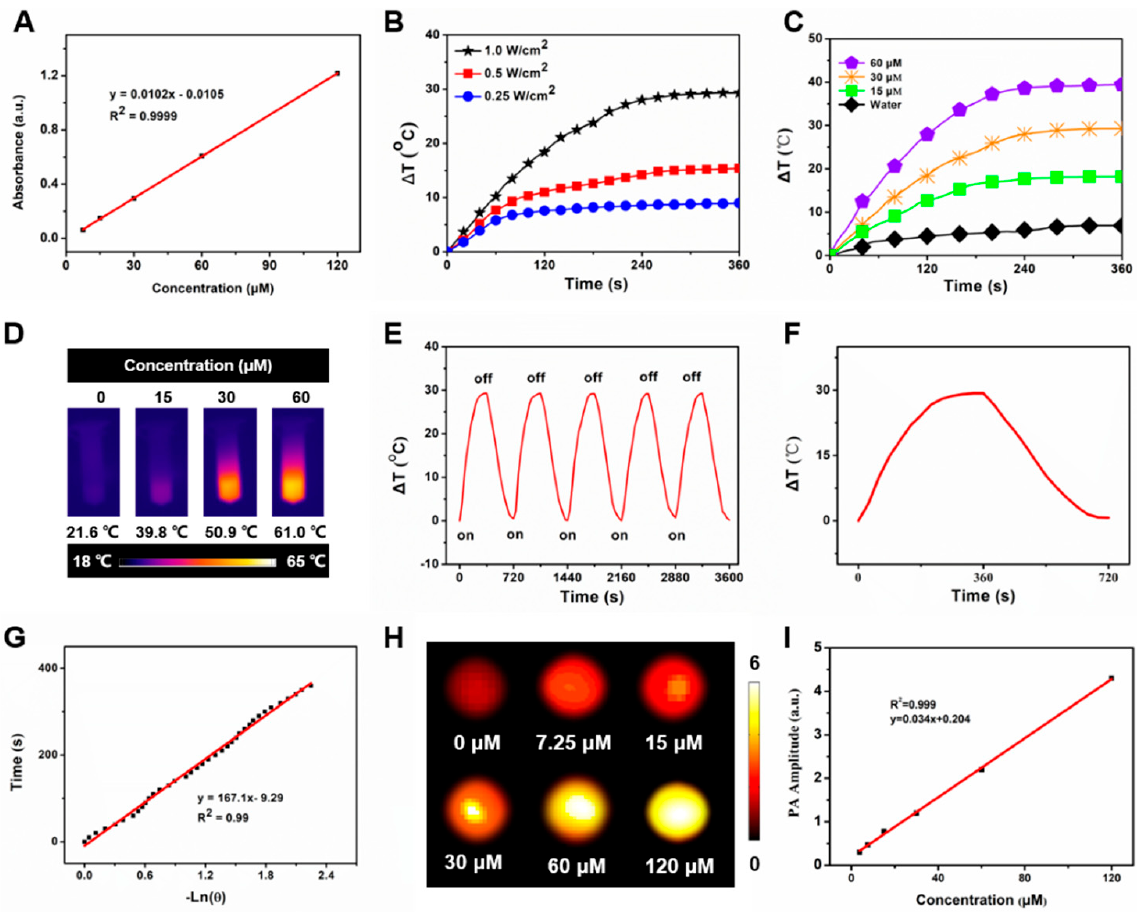
Figure 2. In vitro photothermal performance of MLI. ( A ) Standard curve of IR1048. ( B ) Temperature behavior of MLI upon various 1064 nm laser powers (1.0, 0.5 and 0.25 W/cm 2 ). ( C ) Temperature evolution curves of MLI with various concentrations (IR1048 equivalent to 0, 15, 30 and 60 μ M) upon 1064 nm excitation. ( D ) Thermal images of MLI solution with various concentrations (IR1048 equivalent to 0, 15, 30 and 60 μ M) upon 1064 nm laser irradiation. ( E ) Temperature variation of MLI through 5 laser on/off cycles. ( F ) Photothermal behavior of MLI during heating and cooling period. ( G ) Linear correlation between the time and − ln θ calculated from the cooling database. ( H ) In vitro PAI with various concentrations of MLI (IR1048 equivalent to 0, 7.25, 15, 30, 60 and 120 μ M). ( I )